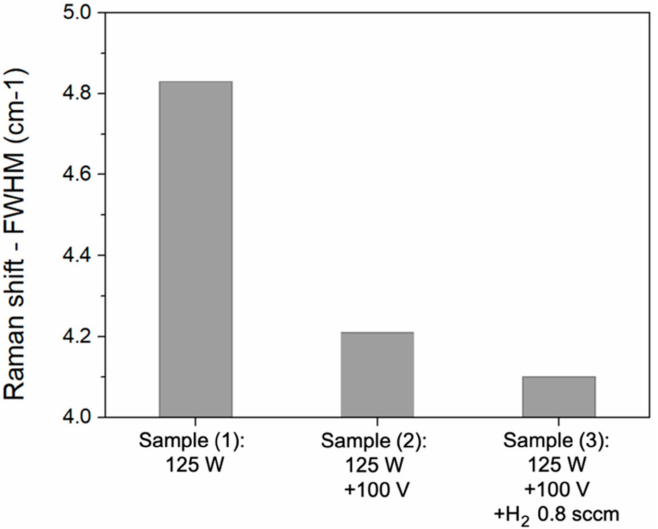
Figure 4. The Raman shift FWHM of the Ge